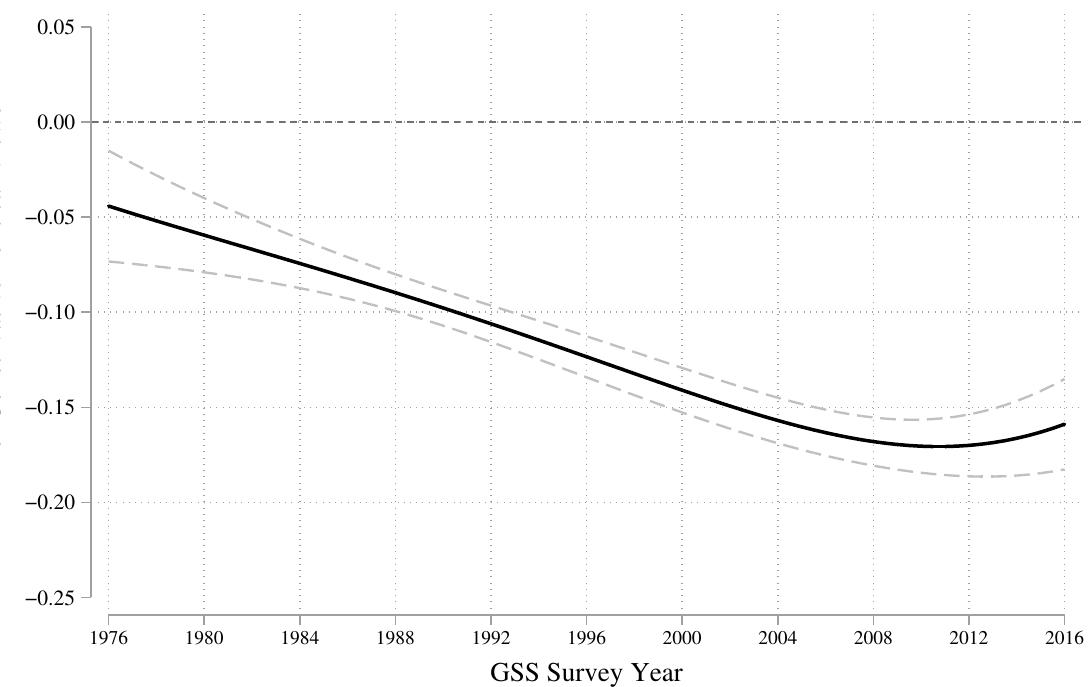
Figure 16: Average marginal effect of conservative political views on the probability of viewing same-sex relationships as acceptable across GSS survey